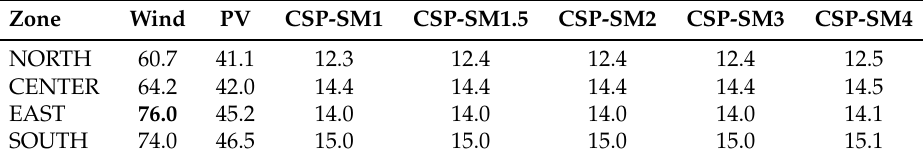
Table 6. Maximum-penetration ratios (yr/T e ) given by (13).